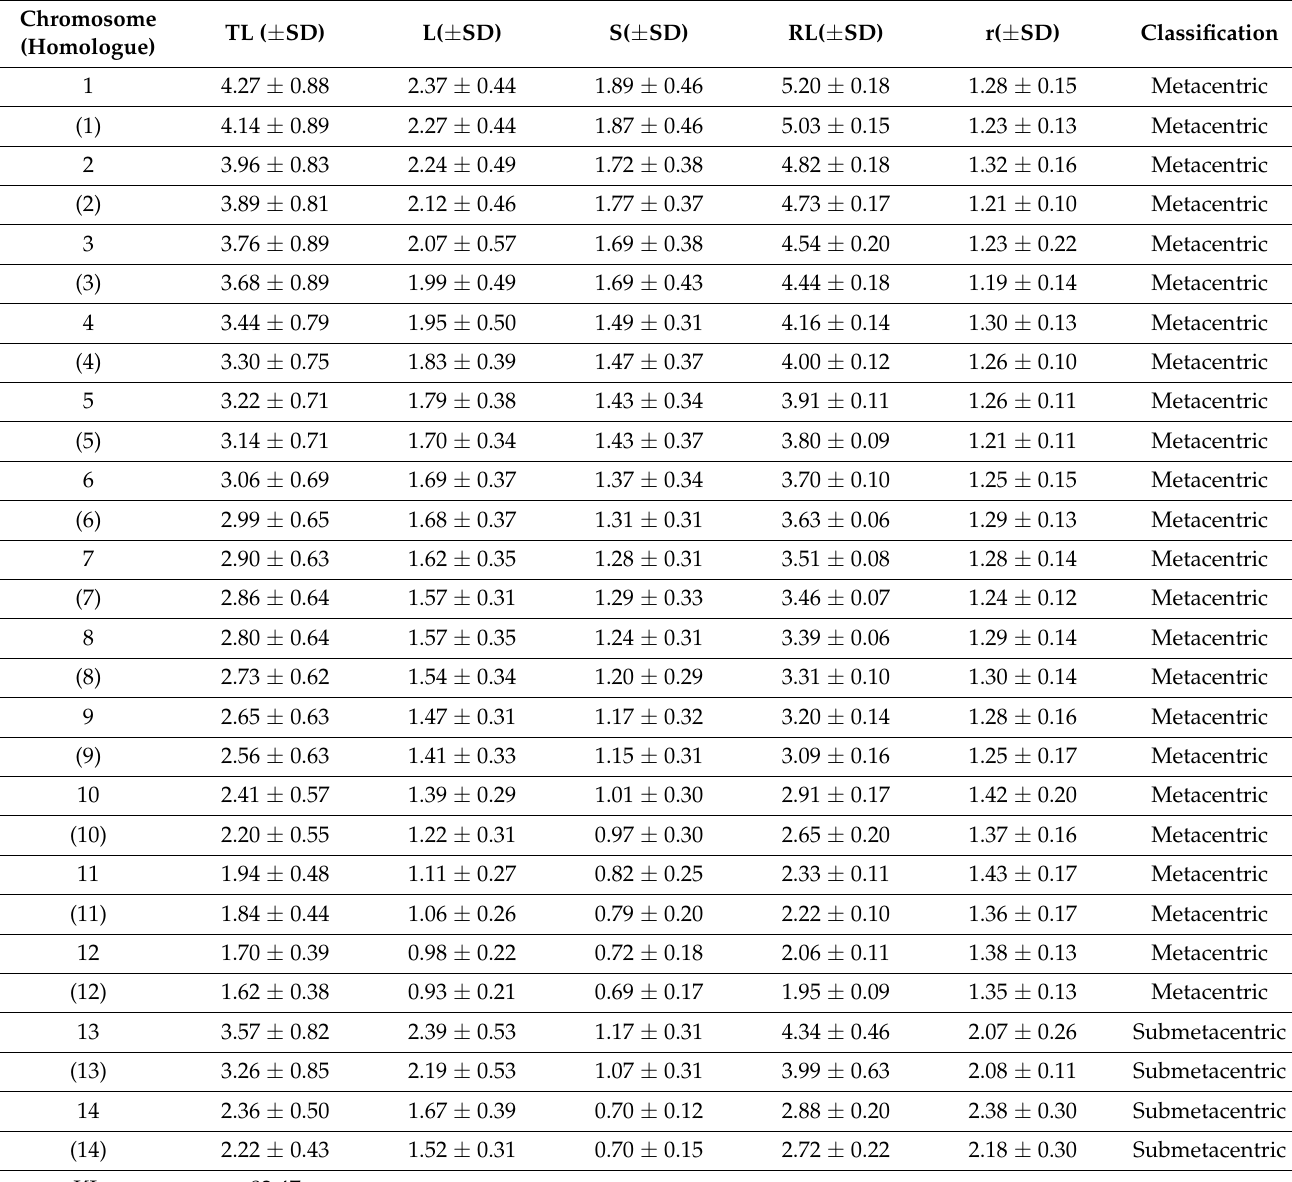
Table 2. Karyomorphometric analyses of the chromosomes of Myrmicocripta sp. All measurements are given in “ µ m”. TL: total length; L: long arm length; S: short arm length; RL: relative length; r: arm ratio; KL: karyotype